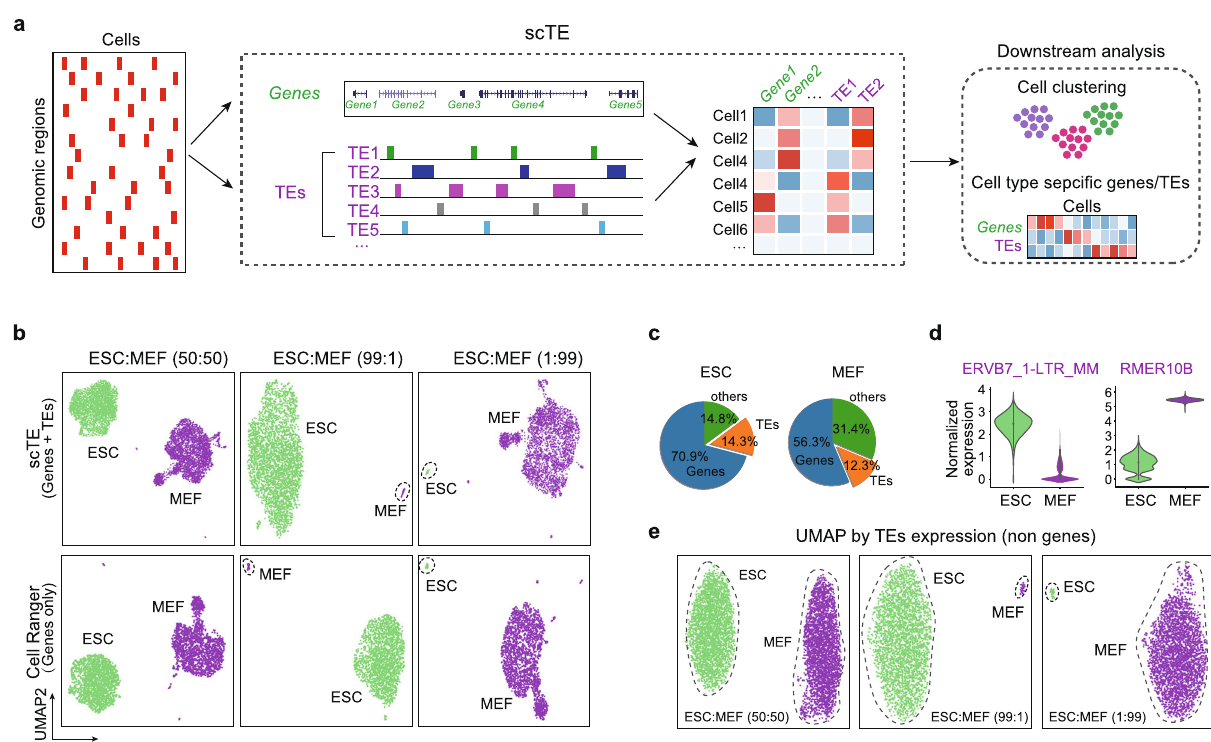
Fig. 1 scTE work fl ow and applications. a Schematic of the workings of scTE. For scRNA-seq data the reads are mapped to the genome, and assigned to either a gene, or a metagene model of a TE. Multimapping read data will assign the best mapping read to a type of TE. Reads are always mapped to a gene fi rst, and then a TE if no gene is found. The resulting assignments are then collapsed into a matrix of read counts for each cell, versus each gene/TE. This matrix can be used in downstream applications. Genes are colored in green and TEs are colored in purple in all fi gures. b UMAP plot showing mixtures of MEFs and ESCs in the indicated ratios. The top panels show scTE analysis, the lower panels show Cell Ranger analysis results. Cells are colored by their sample of origin. c Percentage of reads mapping to genes, TEs or other regions of the genome in MEFs and ESCs. d Violin plot showing the expression of selected TEs in MEFs and ESCs. e As in ( b ), but only TE expression was